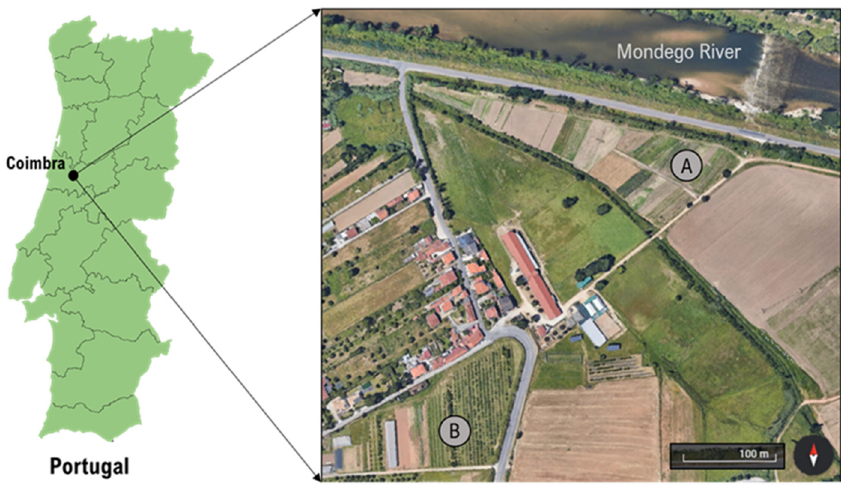
Figure 1: Geographic location of the study site ( A: horticultural fi eld and B: orchard